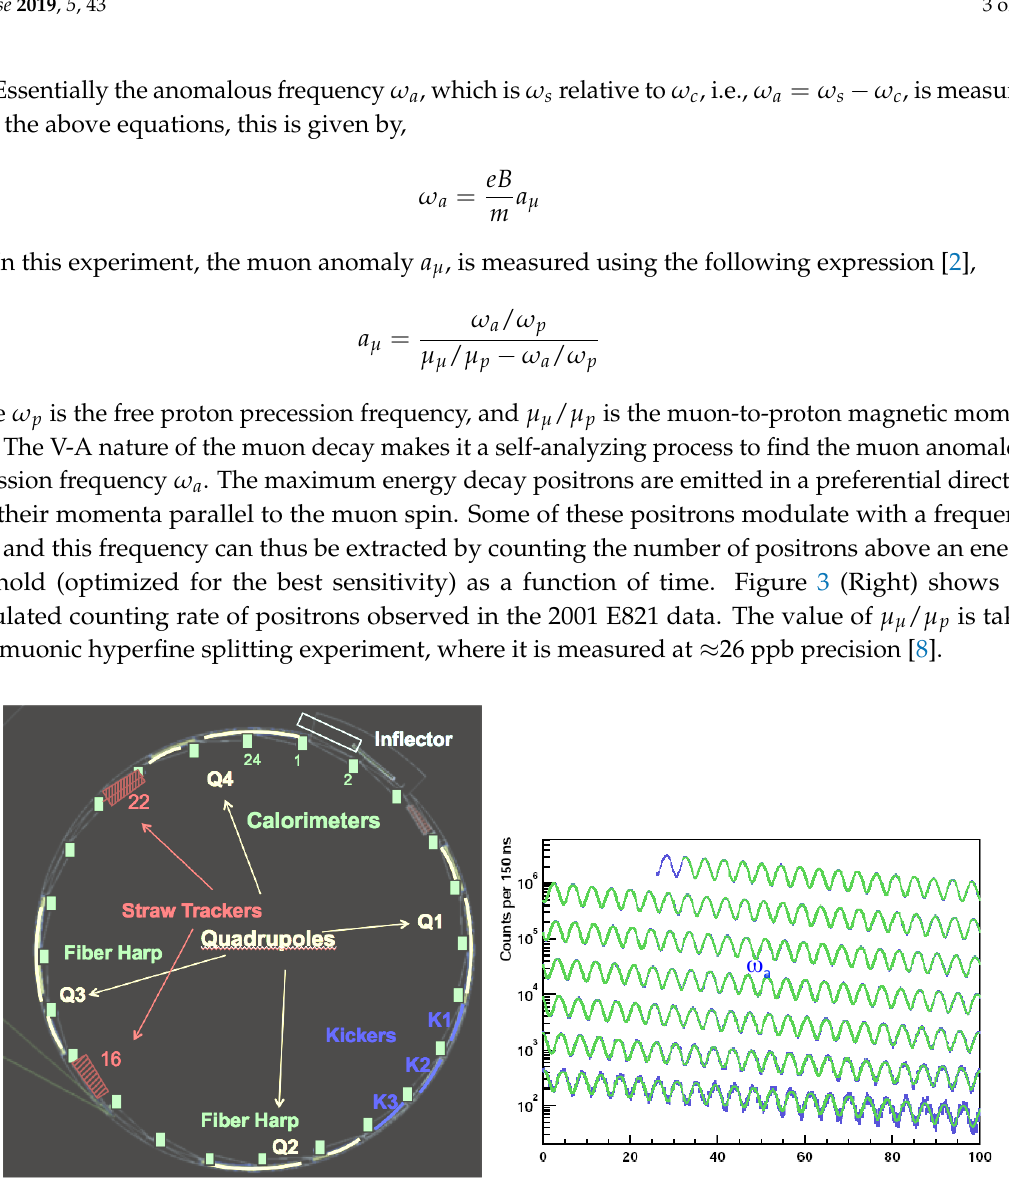
Figure 3. ( Left ) The layout of the storage ring for the E989 experiment; and ( Right ) the modulated counting rate of the positron distribution of 2001 E821